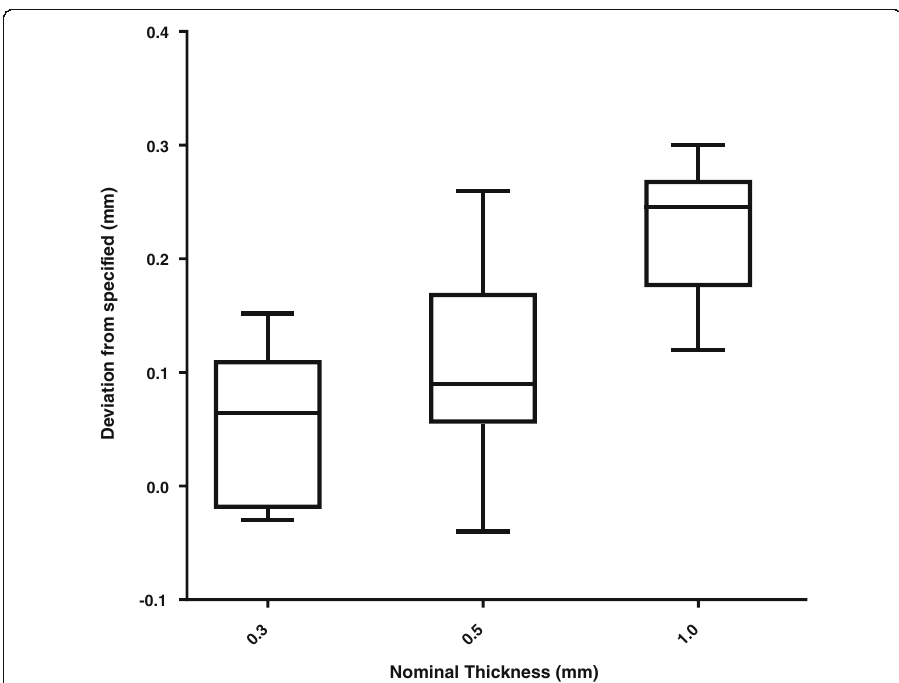
Fig. 5 Box plot of SLM production accuracy for different nominal thicknesses of disk